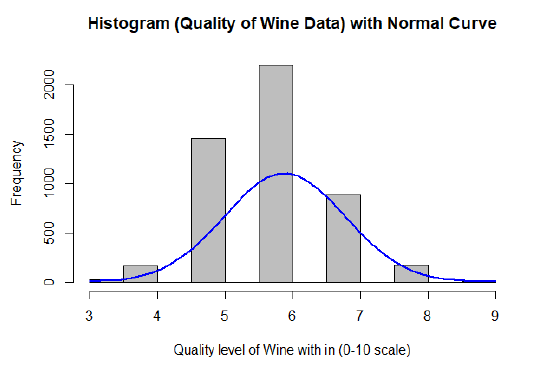
Figure 2. Split the Data into Quality of Wine (Train and